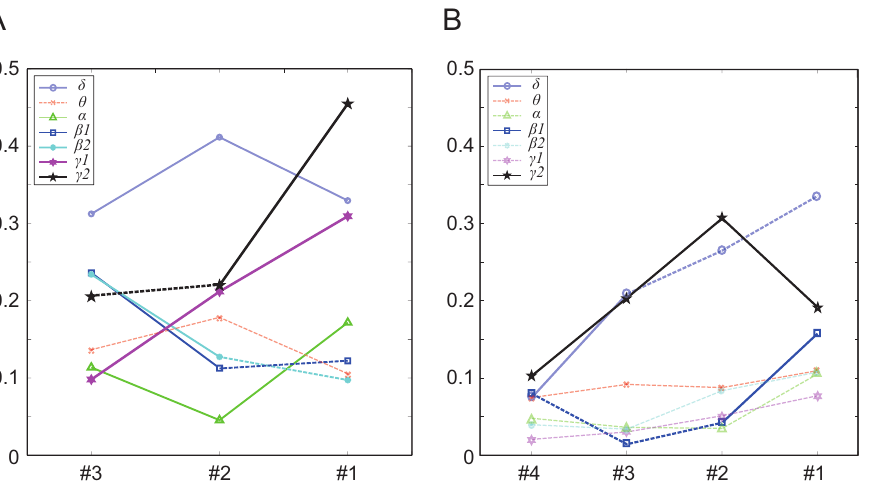
Figure 7. Simple main effect of electrode location contributing to EMG prediction. Each panel shows results of multiple comparisons among the locations for each frequency band level (A: monkey A, B: monkey B). Each marker displays the mean of the median weights. Faded lines show non-significant frequency bands. Solid lines represent a significant difference between weight values ( p , 0.001) and the dotted lines represent no significance. The # indicates the location of the ECoG